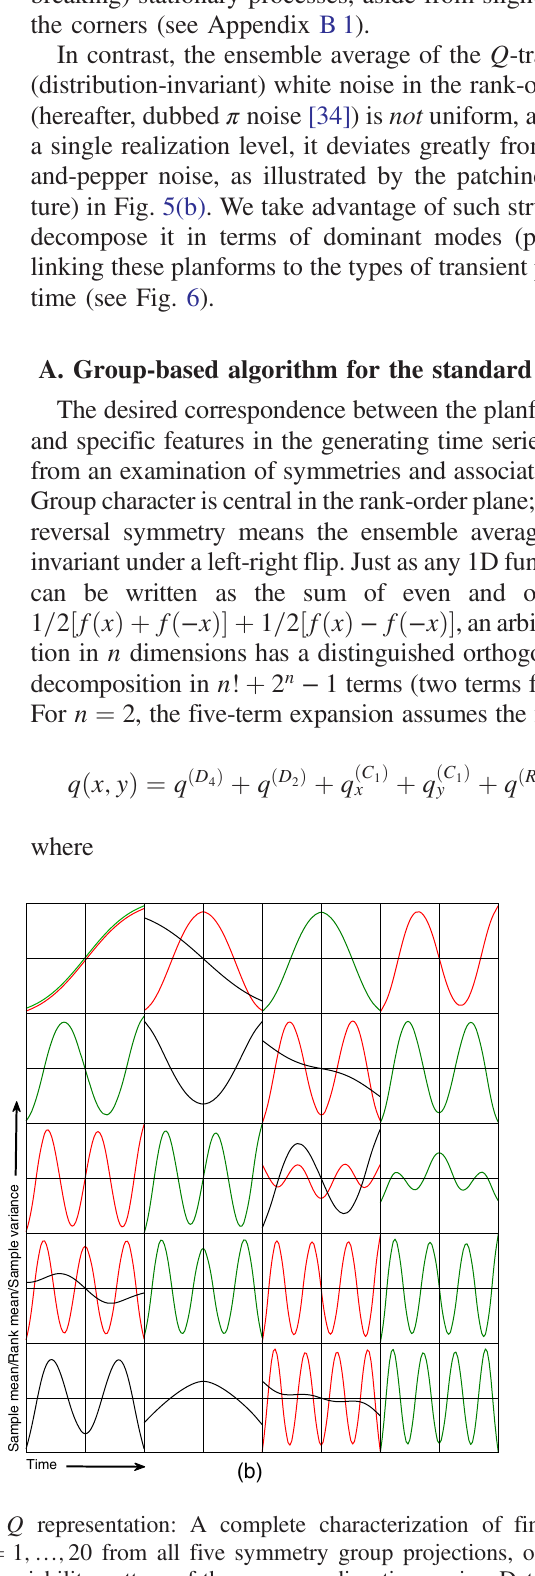
FIG. 6. Universal modal decomposition of iid noise in the Q representation: A complete characterization of finite sample nonstationarity. (a) Combined Q matrix PCA modes ψ k for k ¼ 1 ; … ; 20 from all five symmetry group projections, ordered (left to right) by decreasing singular value. (b) Leading-order sample variability pattern of the corresponding time series: Data mean δμ k (green lines), data variance δσ k (black lines), and rank mean δ r k (red